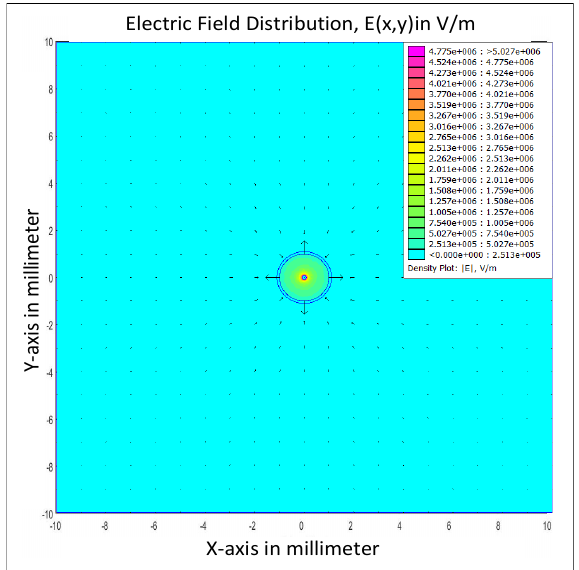
Figure 13. The electric field distribution of the proposed device when the diameter of the thin wire is